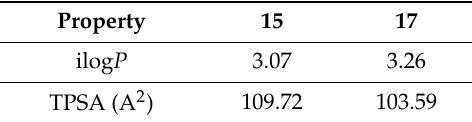
Table 3. Calculated physicochemical properties.